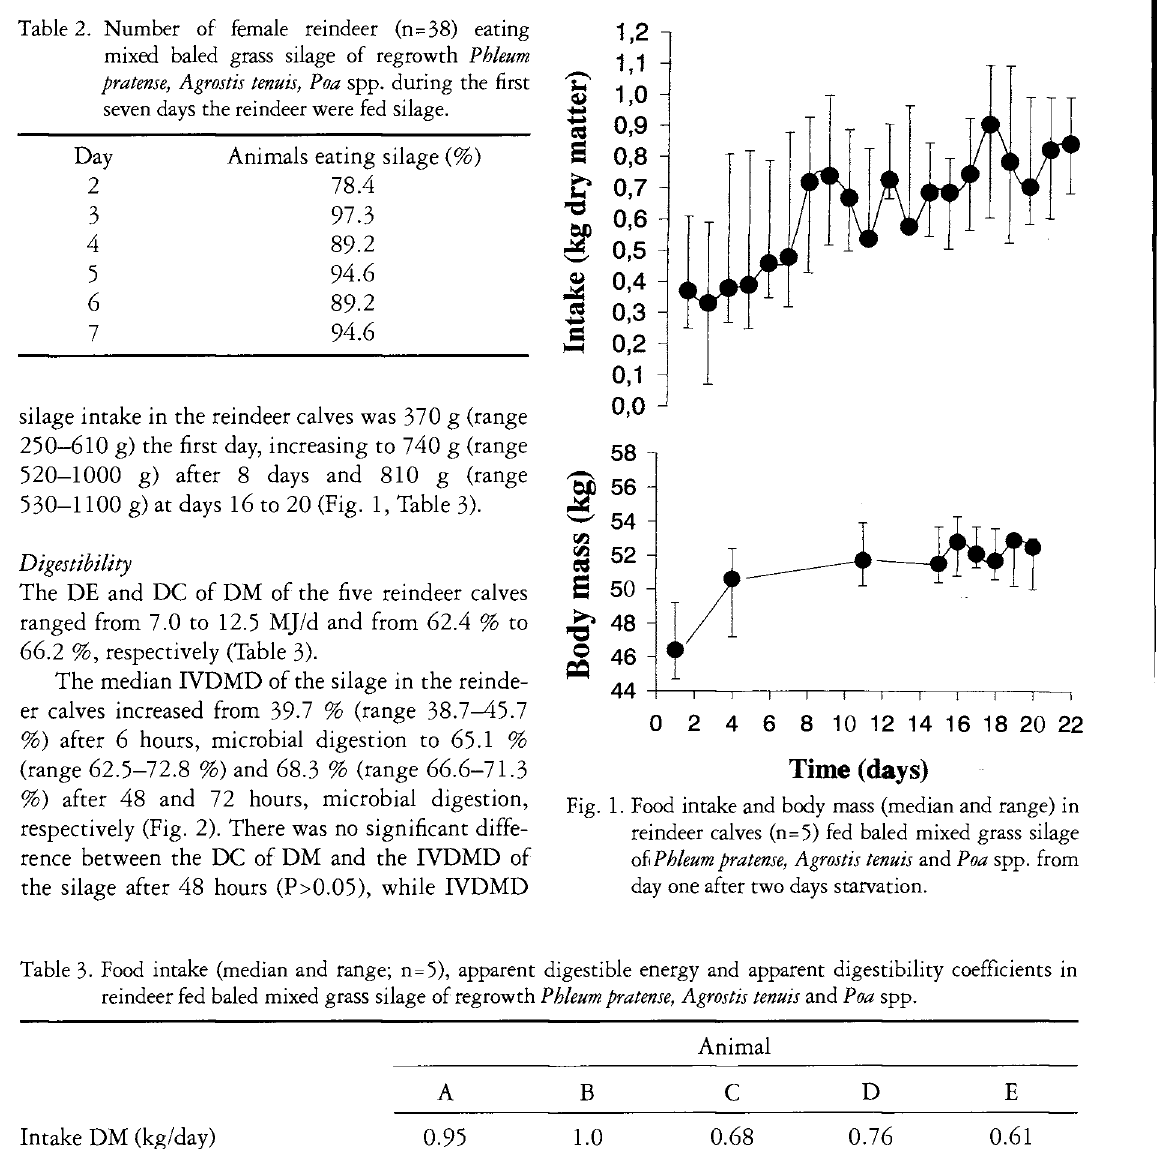
Table 2. Number of female reindeer (n=38) eating mixed baled grass silage of regrowth Phleum pratense, Agrostis tenuis, Poa spp. during the first seven days the reindeer were fed silage.